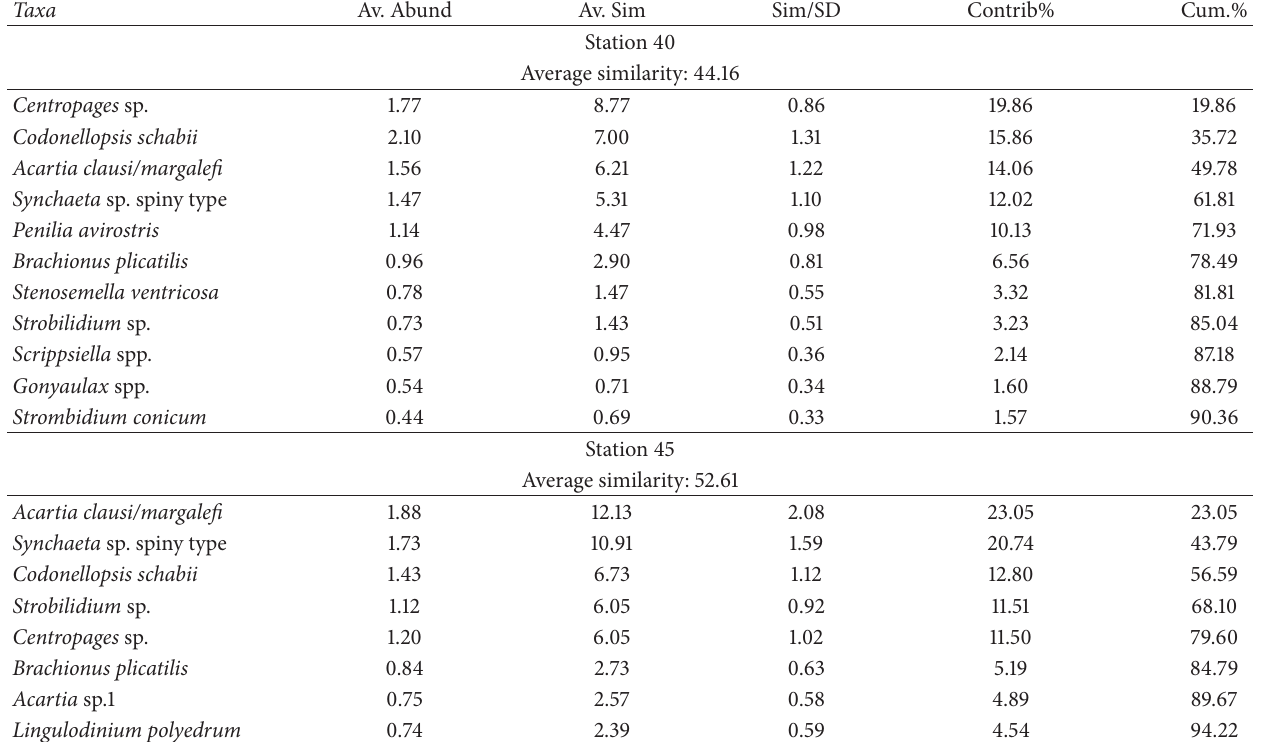
Table 5: Results of SIMPER analysis for resting stages in sediment cores collected at stations 40 and 45 in Bay of Vlor¨e. Taxa Av. Abund Average similarity: 44.16